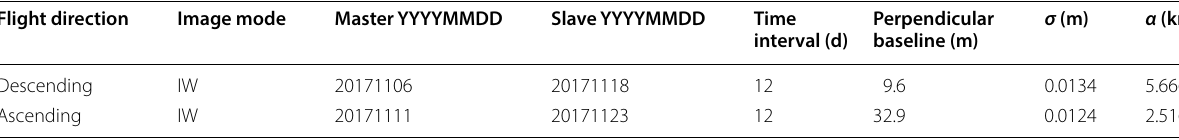
σ : Standard deviations are calculated with all points in the undeformed area α : The e-folding correlation length scale of the 1D covariance function